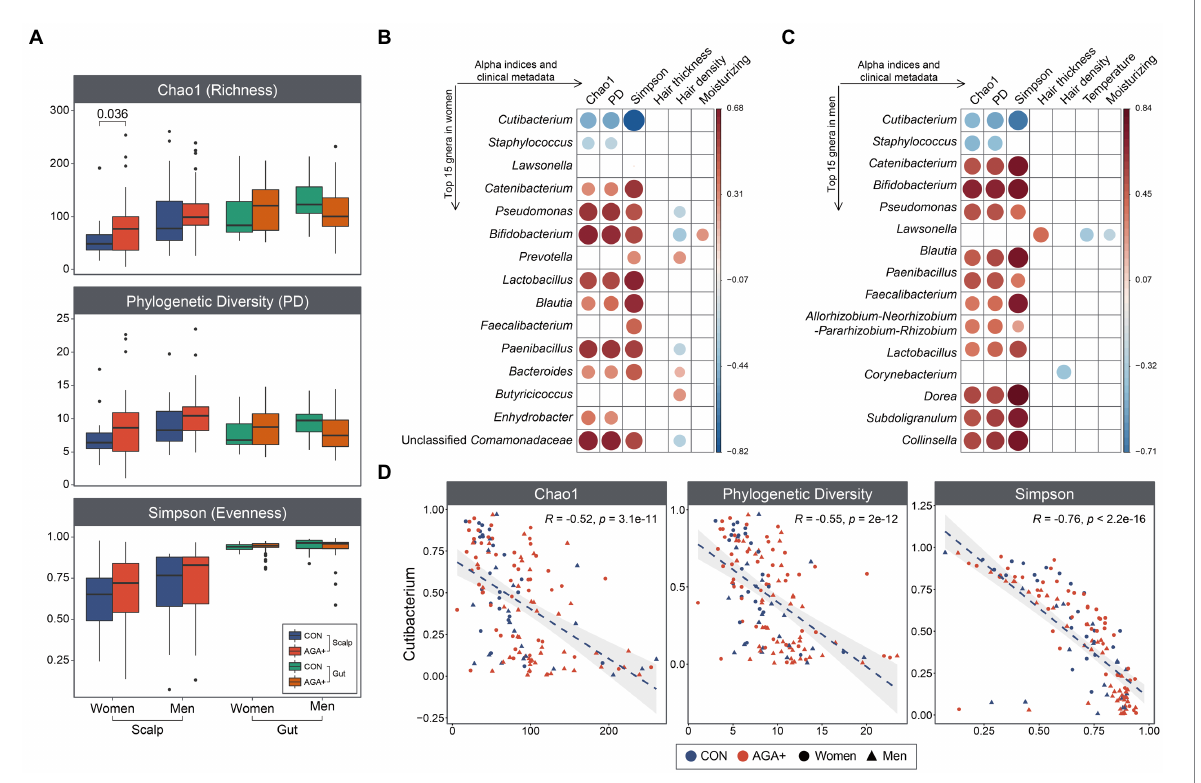
FIGURE 2 Alpha diversity of scalp and gut microbiome, and correlation pattern analysis. (A) The boxplots show the differences in the alpha diversity indices (Chao index, phylogenetic diversity, and Simpson’s index) between healthy controls (CON) and individuals with AGA (AGA+). Spearman’s correlation among the most abundant genera (women, B ; men, C ), alpha diversity indices, and clinical metadata. The color and size of the circles depict Spearman’s coefficient rho with a significant correlation ( p < 0.05). (D) Scatter plots depicting the correlation between Cutibacterium and alpha diversity indices of scalp